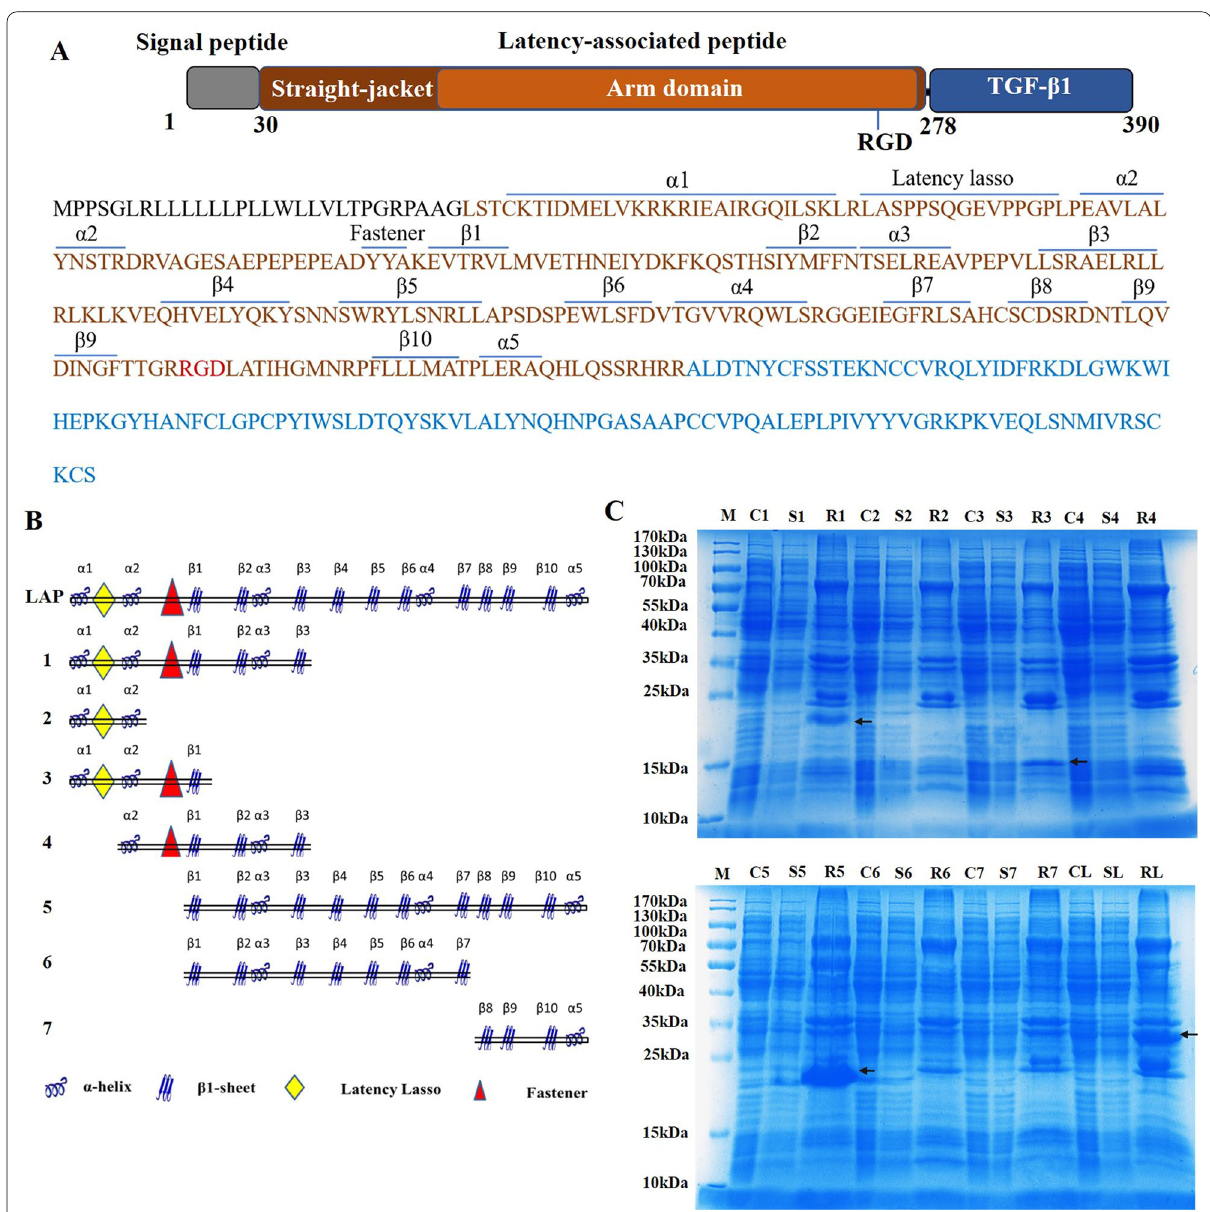
Fig. 1 Truncated PET28a-LAP plasmid construction and expression detection. A Composition of the TGF-β1 proprotein (LAP: brown; TGF-β: blue). B Structural composition of truncated LAP plasmids. C Expression detection of truncated LAP. M, protein marker; C1–C7, Crushing bacterium fluid of No. 1–7; S1–S7, Supernatant of No. 1–7; R1–R7, Ni–NTA agarose of No. 1–7.CL, Crushing bacterium fluid of LAP, SL, Supernatant of LAP; RL, Ni–NTA agarose of